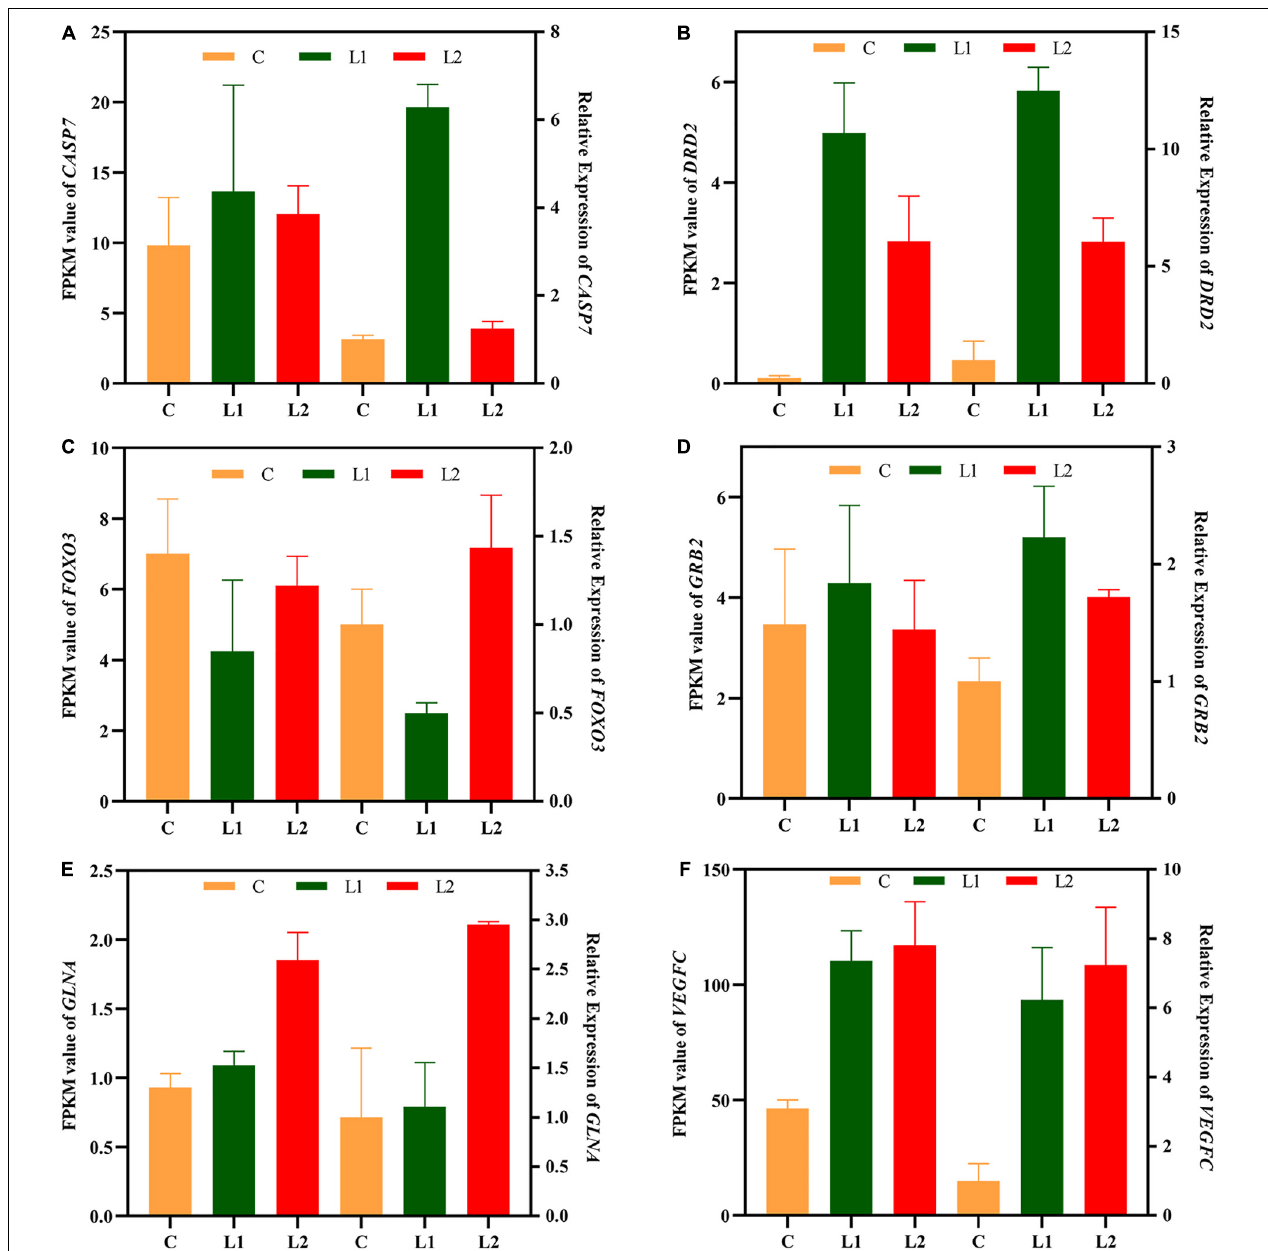
FIGURE 7 | Validation of central nervous system DEGs profiles by qRT-PCR. The x -axis indicates the different experimental groups. The left y -axis indicates the FPKM value of RNA-seq ( n = 3), and the right y -axis indicates the relative expression of 6 genes ( n = 6) in Group L vs. Group C. All data are expressed as the mean ± standard deviation. CASP7 (A) , caspase 7; DRD2 (B) , dopamine receptor D2; FOXO3 (C) , forkhead box O3; GRB2 (D) , growth factor receptor bound protein 2; GLNA (E) , glutamine synthetase; VEGFC (F) , vascular endothelial growth factor